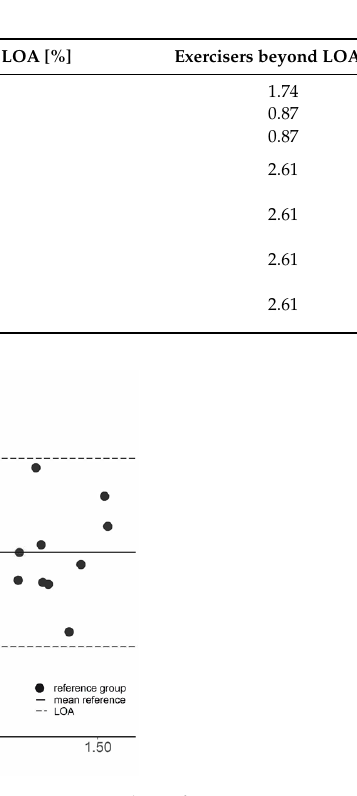
Table 2. Intraclass correlation coefficients (ICC) with 95% confidence interval, upper and lower limits of agreement (LOA low and LOA up ), and percentage fallers and exercisers that changed in gait quality beyond the limits of agreement.